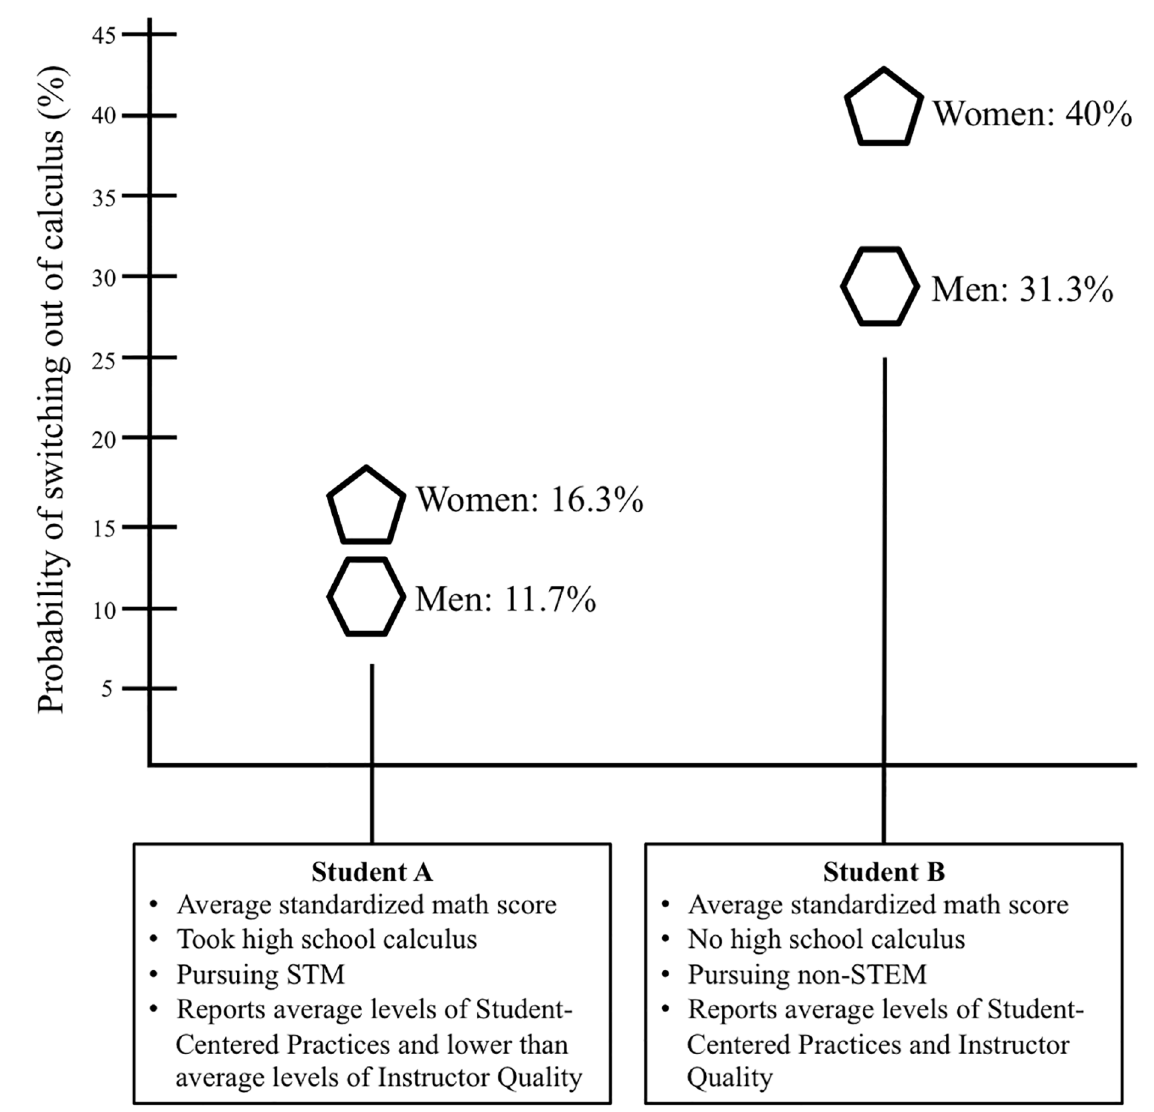
Fig 3. Comparison of probability of switching for two hypothetical students. The hexagon symbol is used to depict a male student and the pentagon symbol is used to depict a female student.